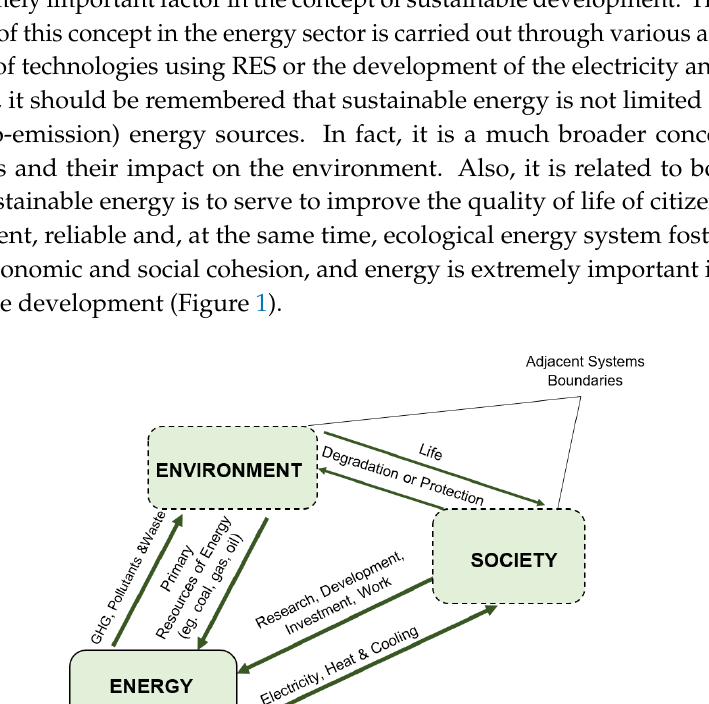
Figure 2. The relationship between the sustainable development of energy and the environment, society and economy.